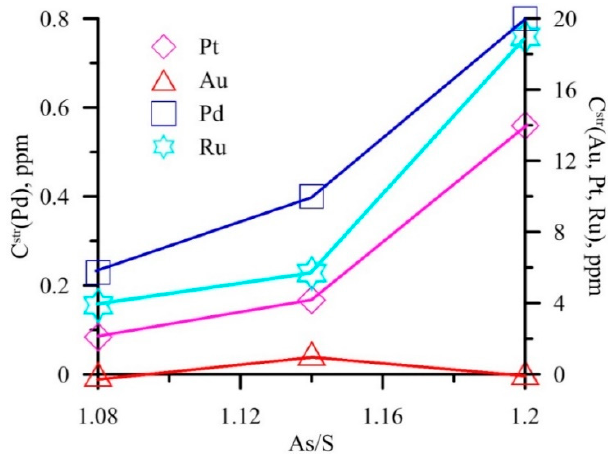
Figure 14. Structurally bound NM as a function of the As / S ratio in arsenopyrite crystals. See Tables 2 and 4 for numerical data.